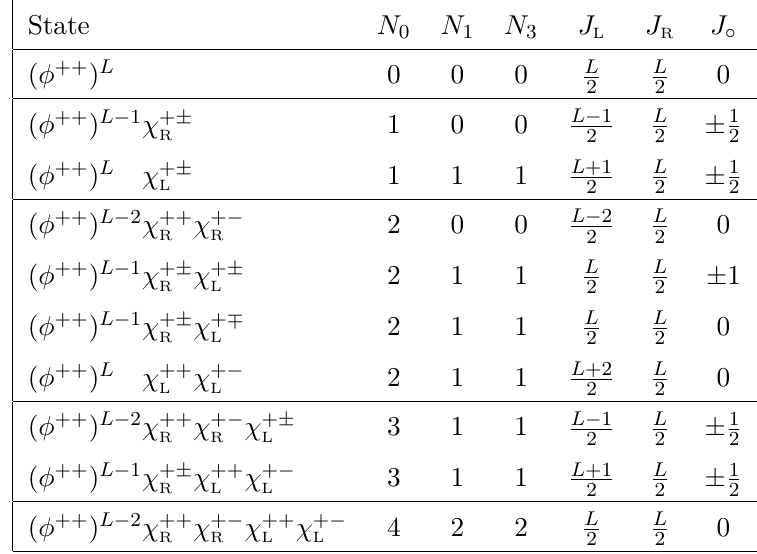
Table 3. The sixteen 1/2-BPS states obtained from a spin-chain ground state of length L by inserting the four fermionic zero modes, and the corresponding excitation numbers and charges under su(2) , su(2) and su(2) ◦ L R